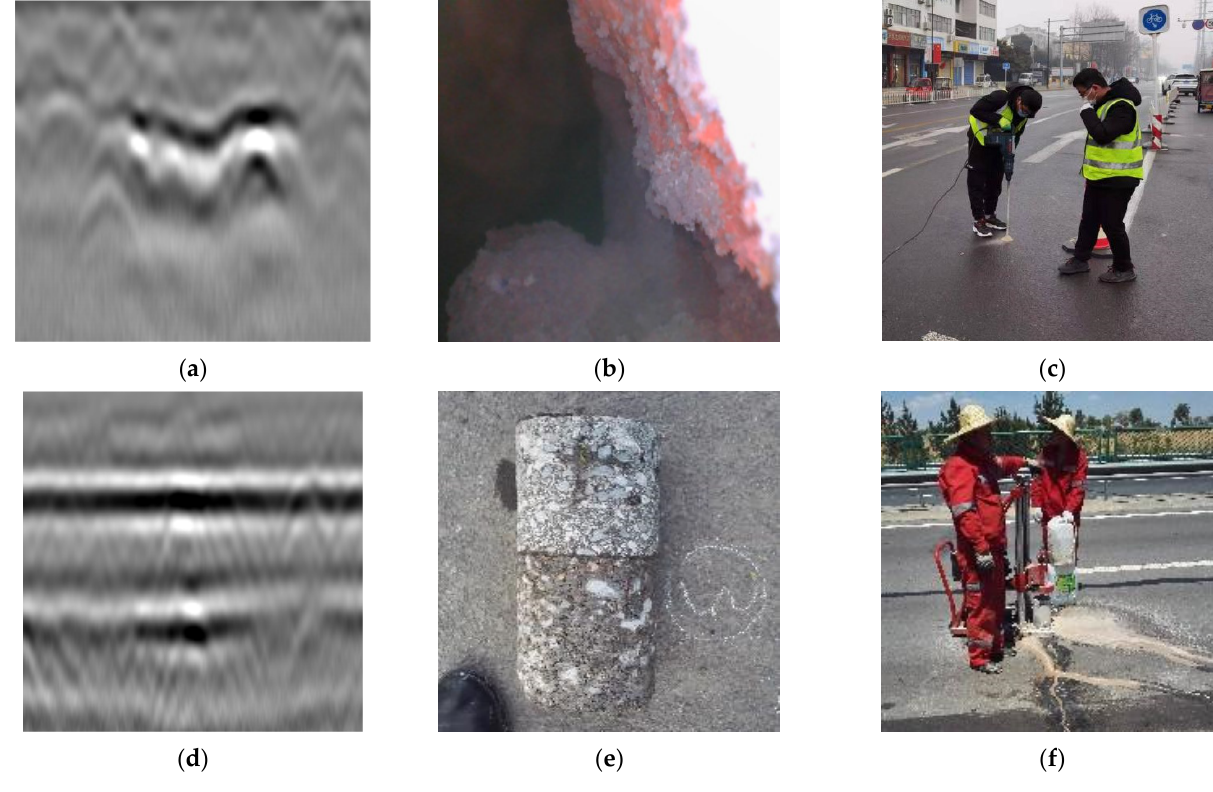
Figure 7. ( a ) The GPR image of cavity; ( b ) cavity was verified by an industrial endoscope; ( c ) field picture at cavity distress location; ( d ) the GPR image of crack; ( e ) crack was verified by coring; ( f ) field picture at crack distress location. Table 2. The statistics of collected field data.